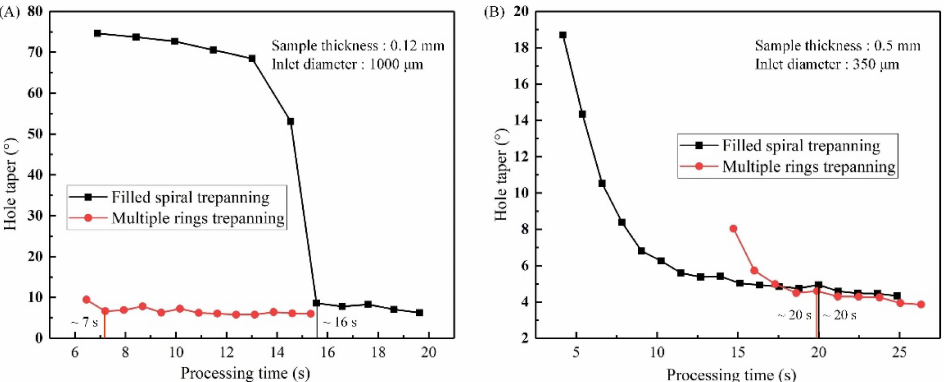
Figure 8. Hole taper vs the processing time ablated using both trepanning patterns, ( A ) Processing time versus hole taper with sample thickness of 0.12 mm and hole diameter of 1000 µ m, ( B ) Processing time versus hole taper with sample thickness of 0.5 mm and hole diameter of 350 µ